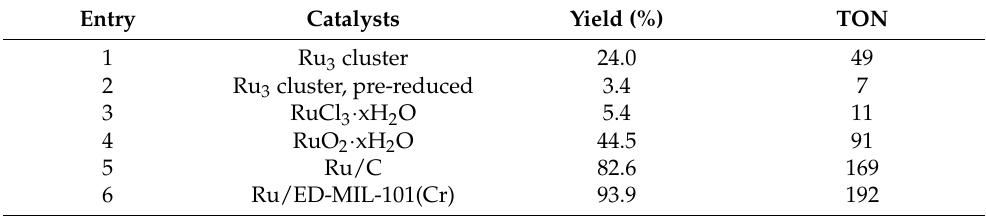
Table 2. Catalytic transfer hydrogenation of benzene to cyclohexane using isopropanol as the hydrogen source over various Ru